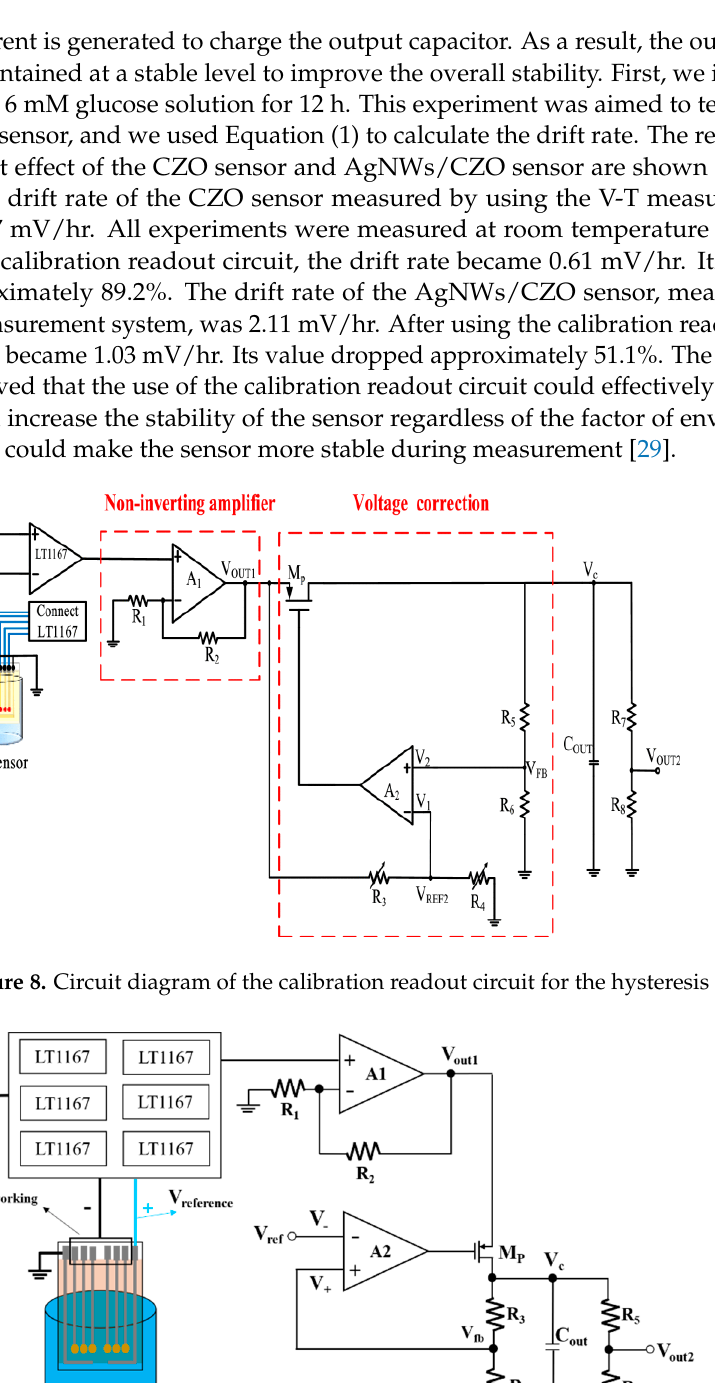
Figure 10. Drift rates of the CZO sensor after using the calibration readout circuit. Figure 11. Drift rates of the AgNWs/CZO sensor after using the calibration readout circuit. 3.4. Hysteresis Effects of the Sensor The hysteresis voltage can be regarded as a kind of value considered suitable for measurement of the recovery degree of the sensor. In this study, the sensor was sequentially immersed under the glucose solutions with different concentrations. The